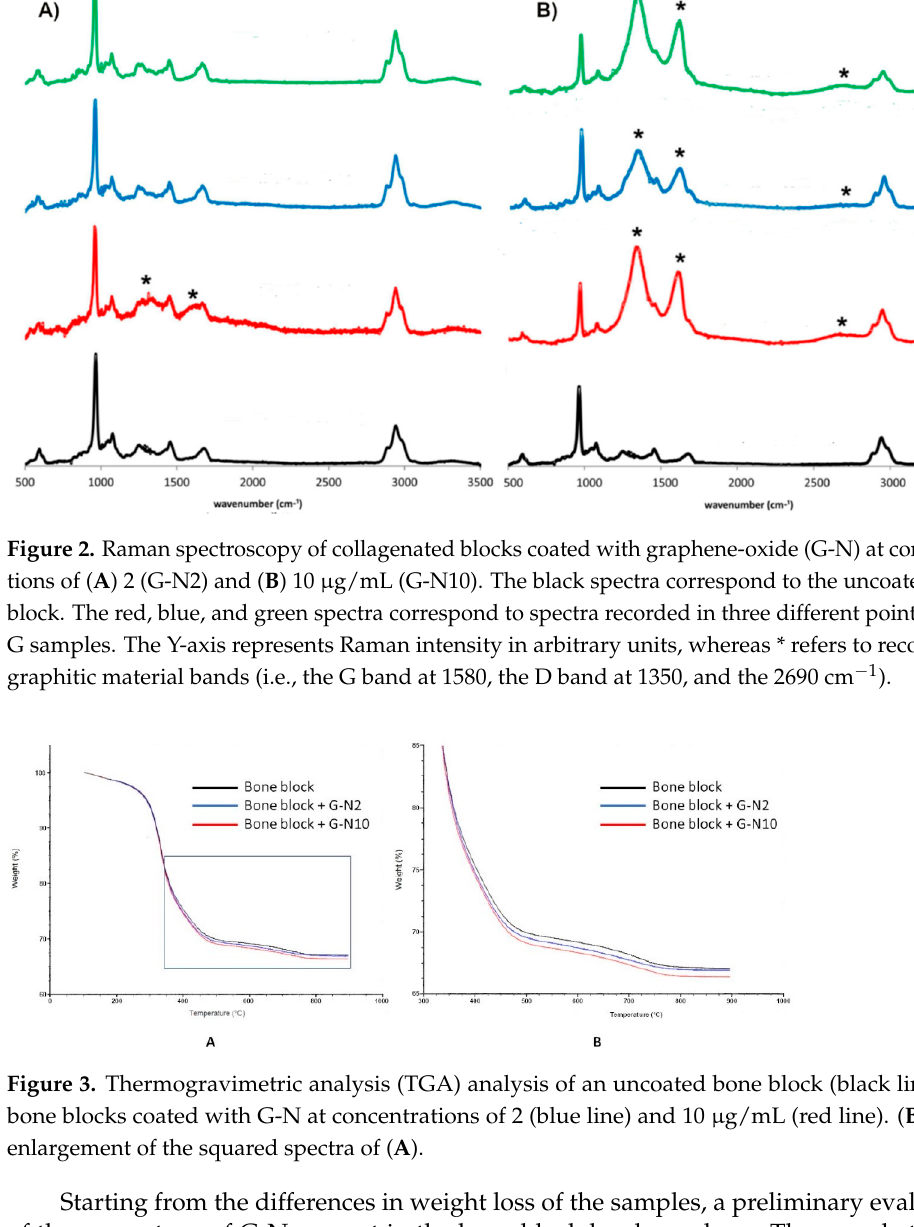
Figure 4. Images of human dental pulp stem cells (hDPSCs) seeded on equine bone blocks, un- coated ( a ), G-N2 ( b ), and G-N10 ( c ), acquired with a fluorescence microscope (40X), scale bar 50 μ M. The pictures show that cells are mostly alive (green spots) after 24 h, while only few of them, indicated by the arrows, are dead (red spots). The evaluation of the hDPSC viability was assessed using the live/dead test (Live/Dead BacLight™, Molecular Probes, Eugene, OR, USA). 3.6. Gene Expression The degree of differentiation was evaluated through the expression of Runx2 and Smad5, key factor transcriptions associated with osteogenic differentiation. For this pur- pose, real-time PCR analysis was performed for SMAD5 and RUNX2 after 7, 14, and 21 days of culture, in both GM and DM conditions. Data derived from three different exper- iments (each n = 3) were presented as Δ Ct means ± standard deviation (Table 1). The more positive the values, the more the genes were downregulated; the more negative the val- ues, the more they were upregulated. The hDPSCs cultured after 7 days in GM showed an increase in SMAD5 gene expres- sion in G-N2+Mel in respect to Ctrl+Mel. After 14 days in GM, no statistically significant differences were found. After 21 days, both G-N2 and G-N10 and G-N2+Mel, andG- N10+Mel gave a significant increase in SMAD5 gene expression in respect to Ctrl and Ctrl+Mel, respectively. The hDPSCs cultured after 7 days in DM showed a decreased gene expression of SMAD5 in the presence of coated bone blocks and coated bone blocks with